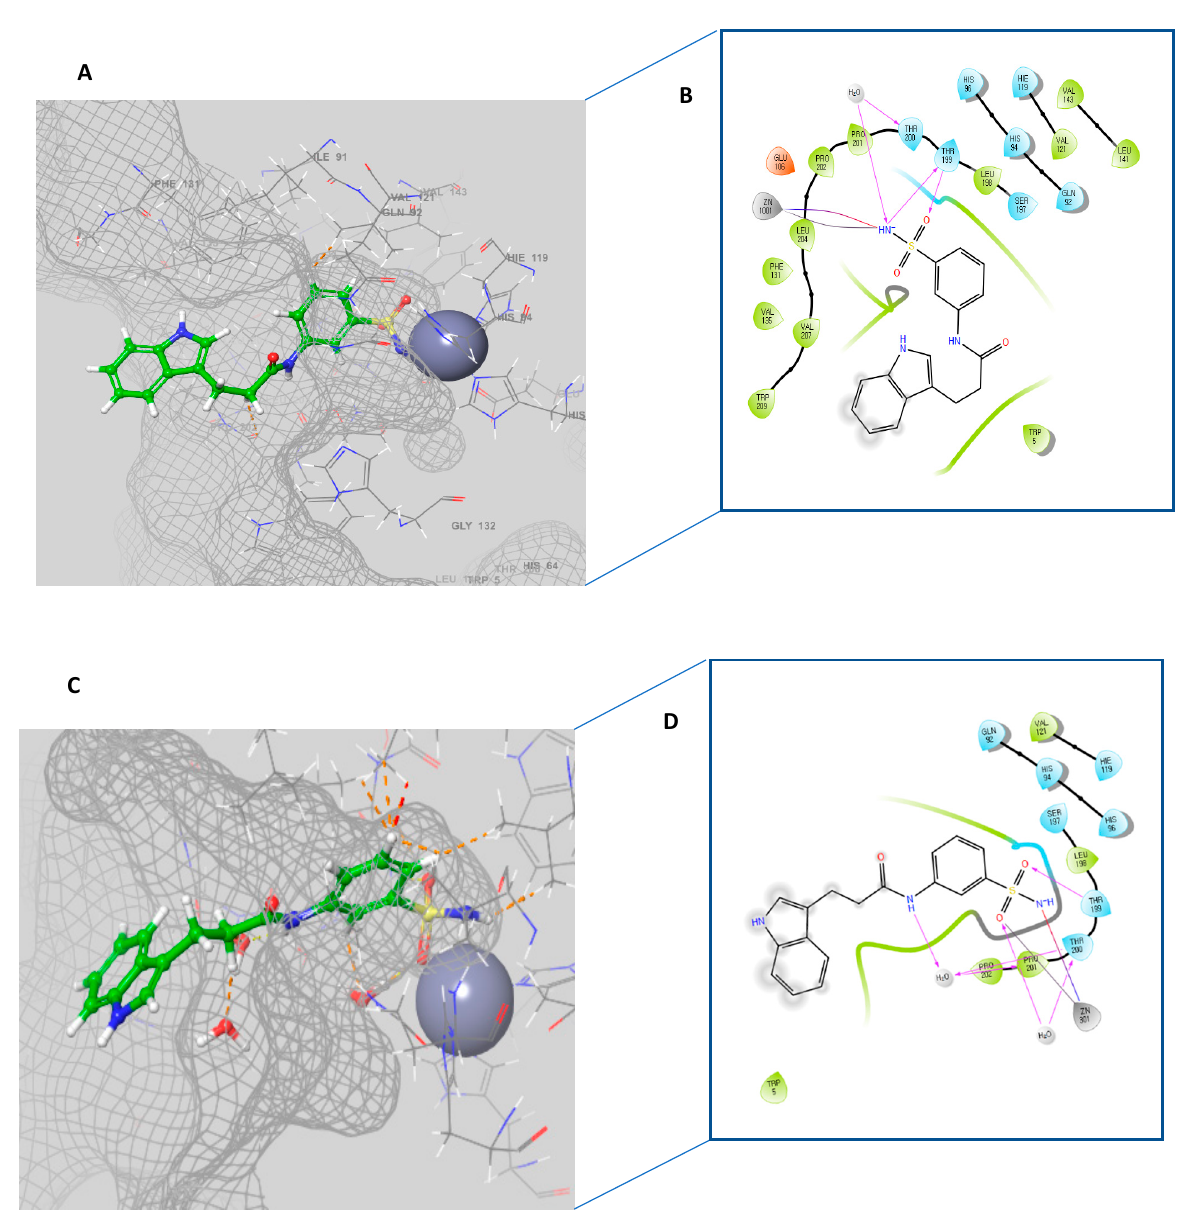
Figure 5. The interaction patterns of compound 2a in the active sites of hCA II and IX. ( A ) 3D model of compound 2a surface hCA II active site, with the surface viewed in the mesh format. ( B ) 2D interaction pattern of compound 2a with hCA II active site. ( C ) 3D model of compound 2a surface hCA IX active site, with the surface viewed in the mesh format. ( D ) 2D interaction pattern of compound 2a with hCA IX active site.